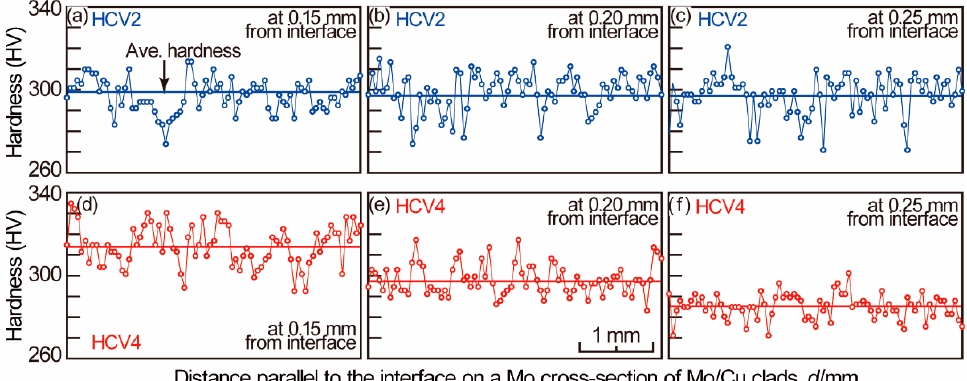
Figure 10. Variation of Vickers hardness with distance parallel to the Mo/Cu interface at the three positions away from the interface on a Mo cross section for the as-explosive-welded ( a – c ) HCV2 and ( d – f ) HCV4 clads obtained at room temperature with an applied load of 0.49